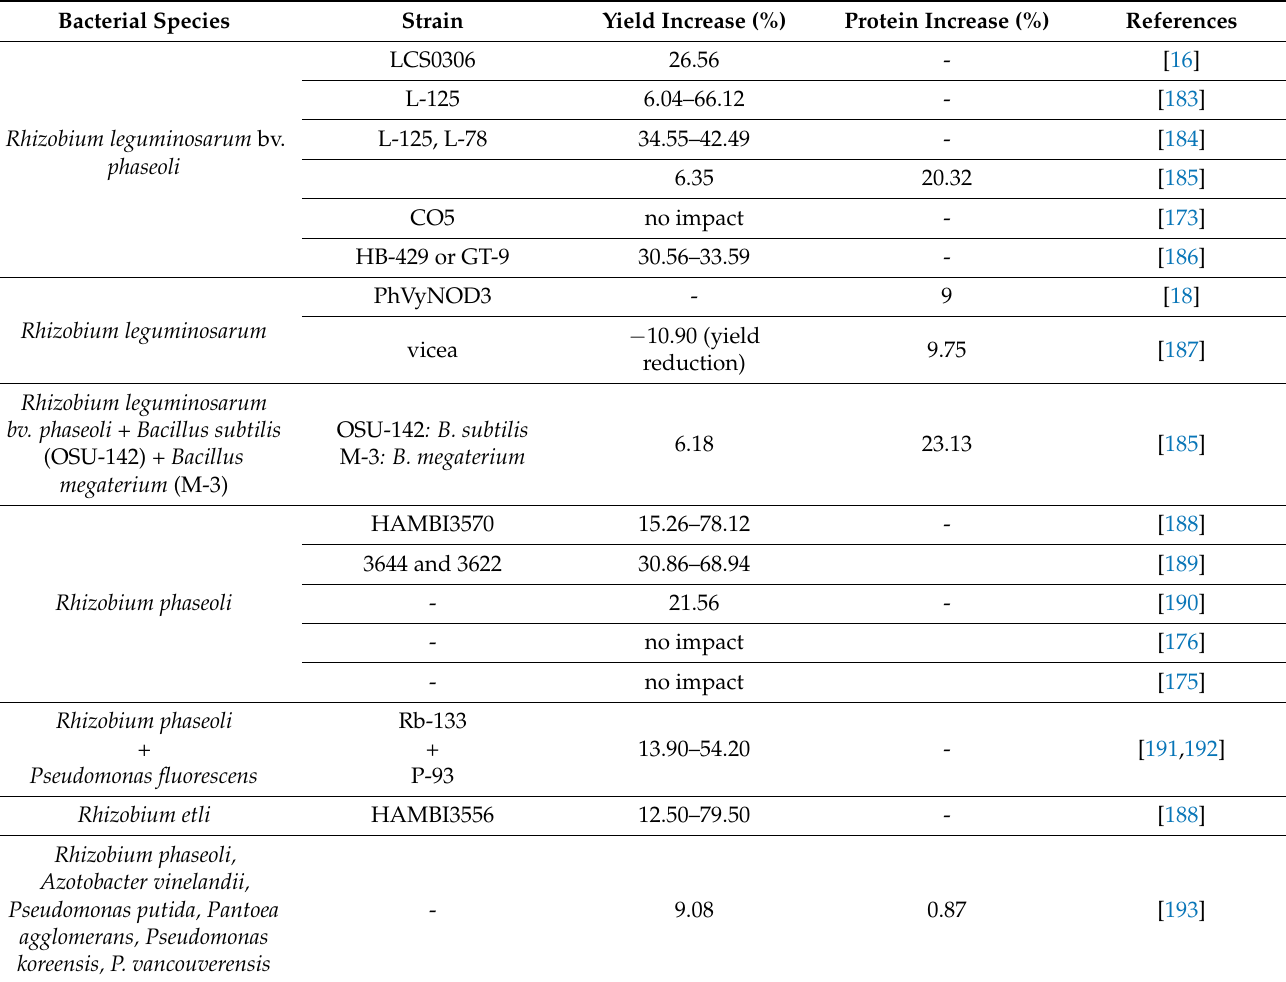
Table 4. Effects of Rhizobium species and plant growth promoting bacteria (PGPB) on common bean yield and protein